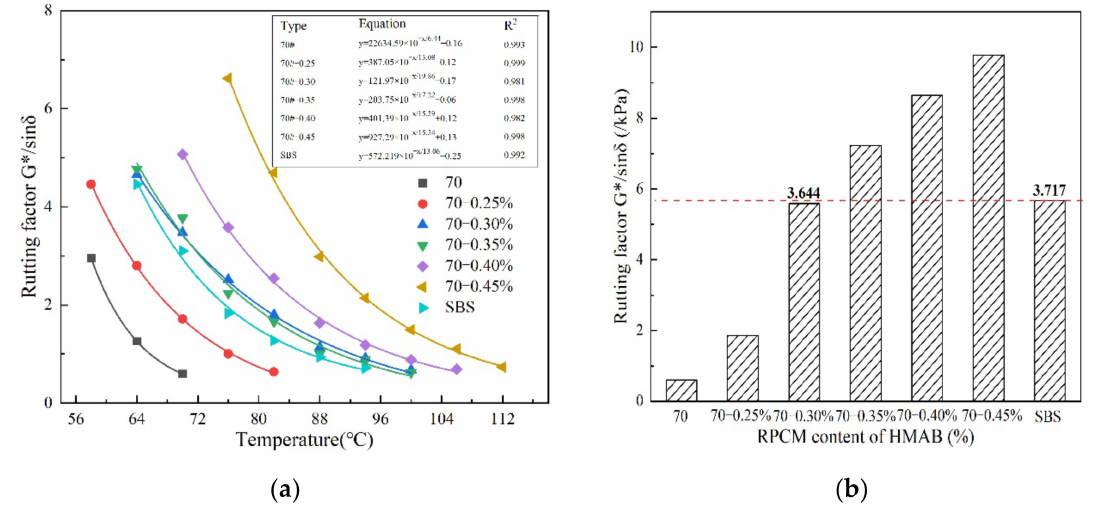
Figure 4. G*/Sin δ temperature results at: ( a ) different RPCM contents, and, ( b ) 70 ◦